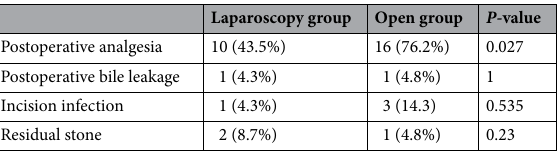
Table 4. Comparison of postoperative analgesia and complications between the two